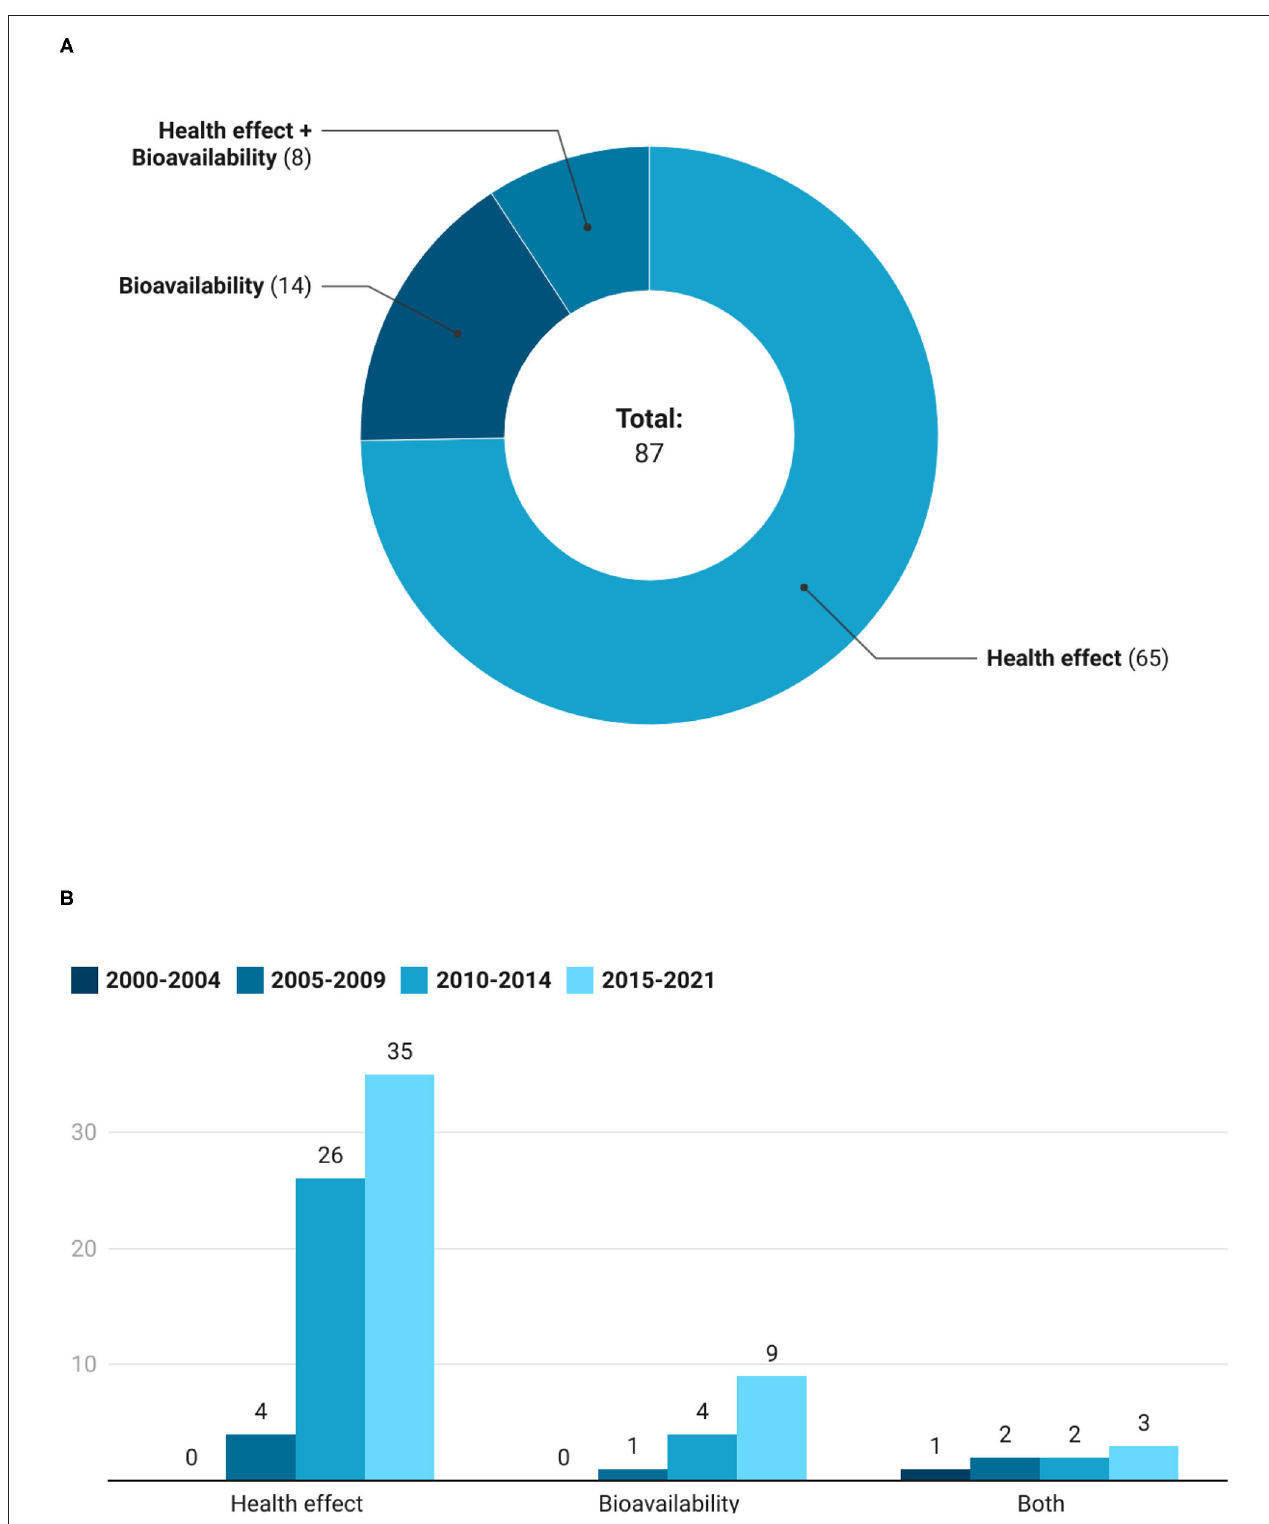
FIGURE 7 | Number (A) and trend (B) of studies that assess bioavailability, health effect, and both bioavailability and health effect of GSLs.